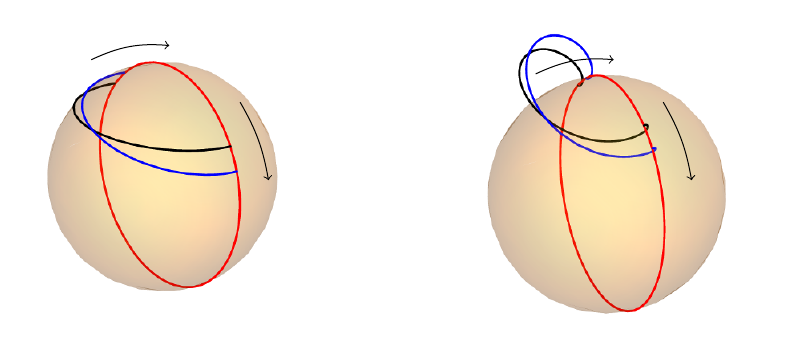
Figure 3 . Stereographic images of the giant magnon (left) and dyonic giant magnon (right) solu- tions at two nearby times (black and blue). The strings end on the orbit of the BMN solution shown in red. The endpoints move along this orbit at the speed of light. The giant magnon obtained by taking (cid:11) = (cid:25) takes values in an S 2 (cid:26) S 5 shown in 2